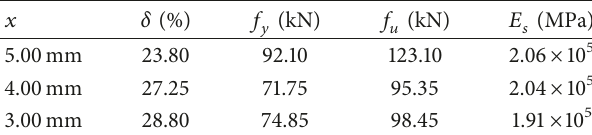
Table 2: Mechanical properties of the